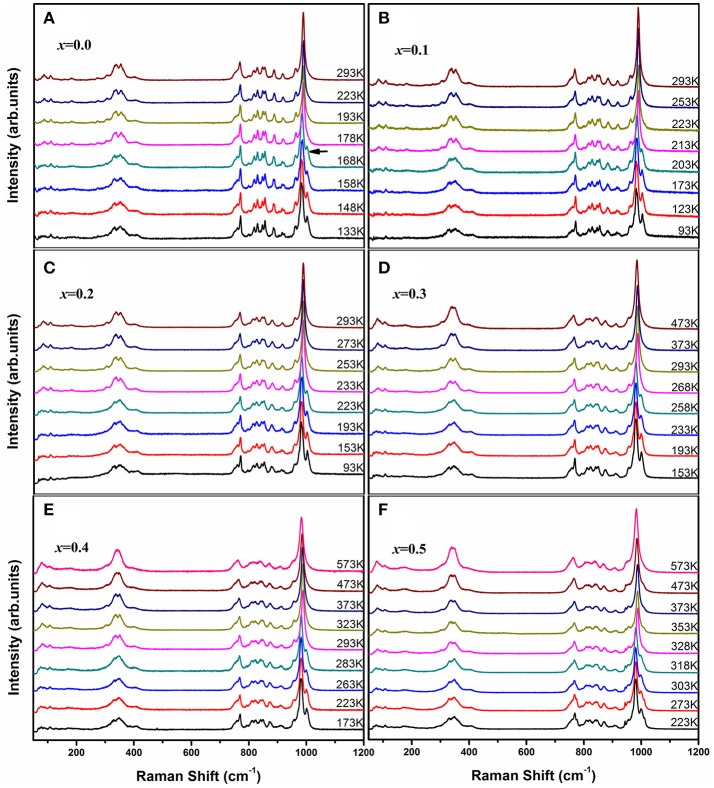
Temperature-dependent Raman spectra of HfMg1−xZnxMo3O12 with x = 0.0 (A), 0.1 (B), 0.2 (C), 0.3 (D), 0.4 (E), and 0.5 (F).